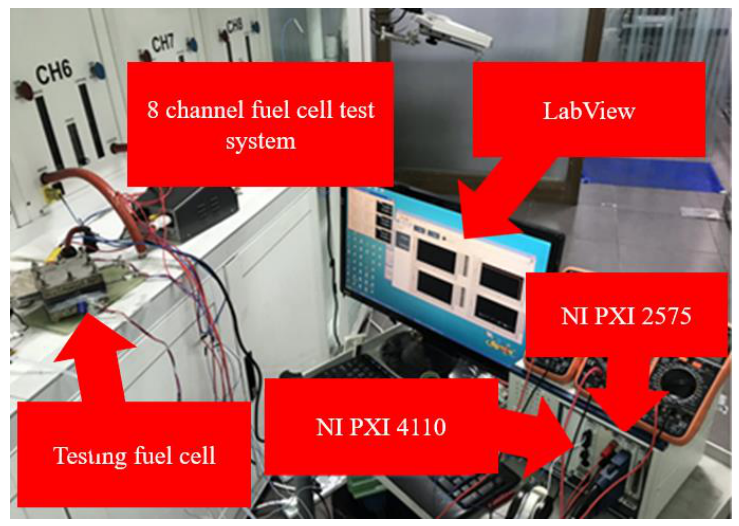
Figure 5. Flow correction test.